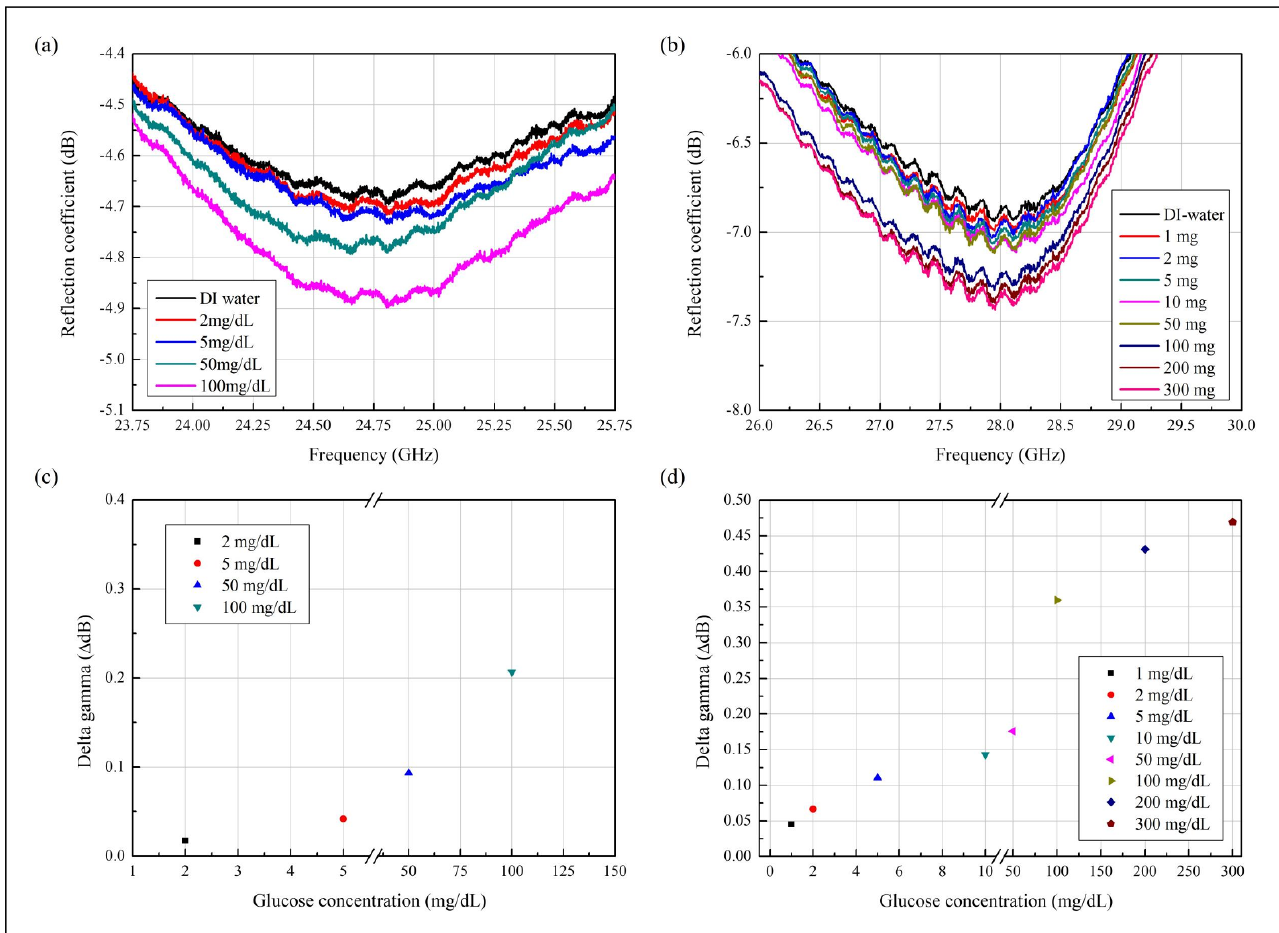
Figure 5. Measured reflection coefficients for the sensor with the ( a ) PDMS wall or ( b ) PDMS channel. Calculated delta gamma of the reflection coefficients for the sensor with the ( c ) PDMS wall at 24.8 GHz and 27.8 °C or ( d ) the PDMS channel at 28 GHz at 22.3 °C.